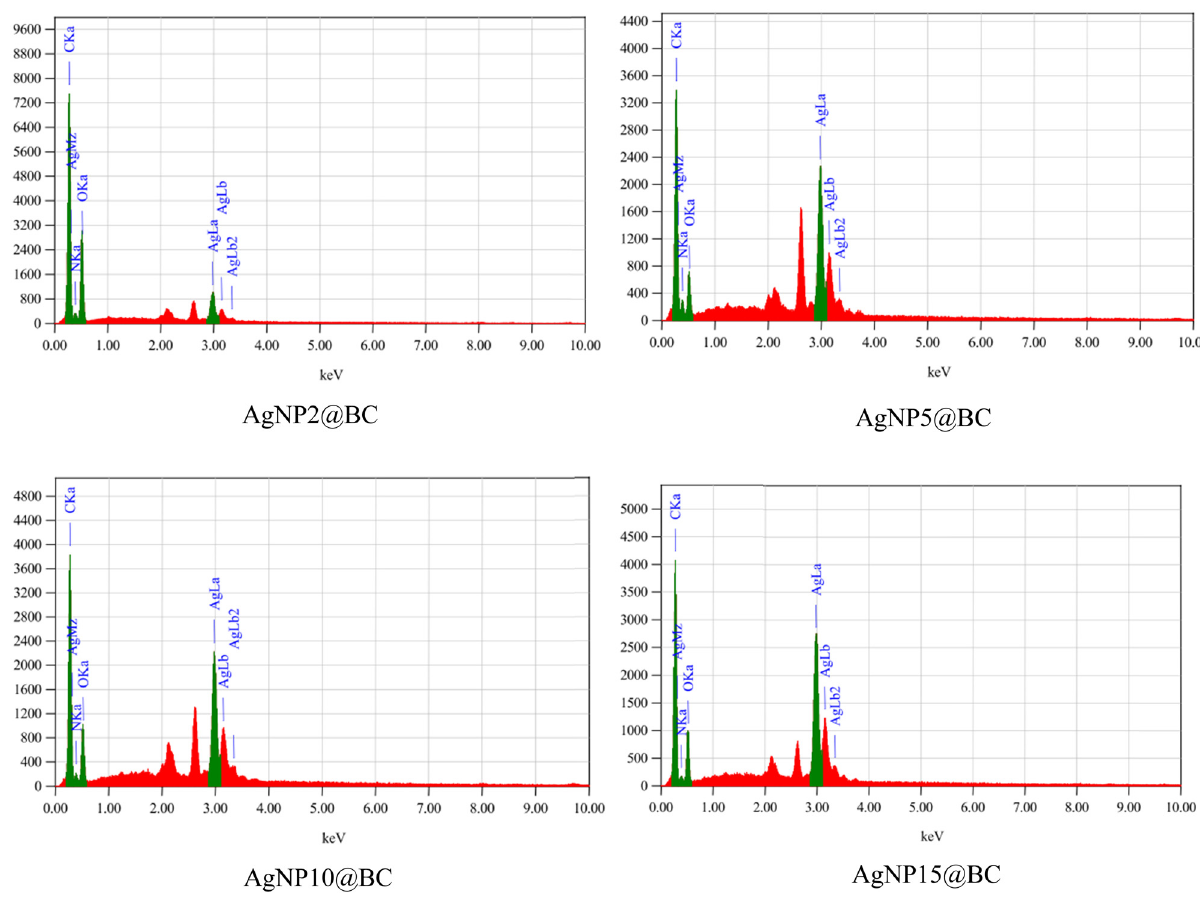
Figure 6: EDX quantitative analysis of AgNPs templated BC.